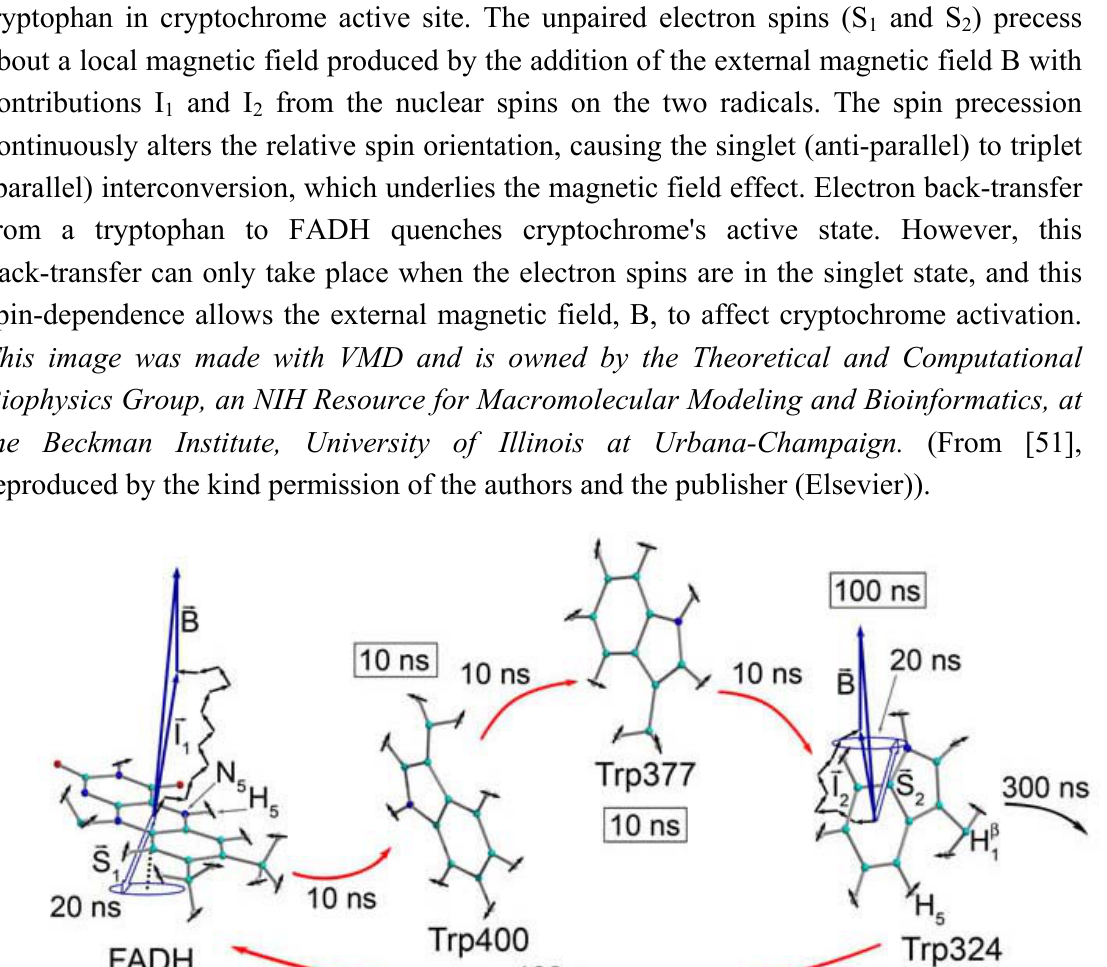
Figure 4. Scheme of the magnetic field effect on the radical pairs between FADH and tryptophan in cryptochrome active site. The unpaired electron spins (S